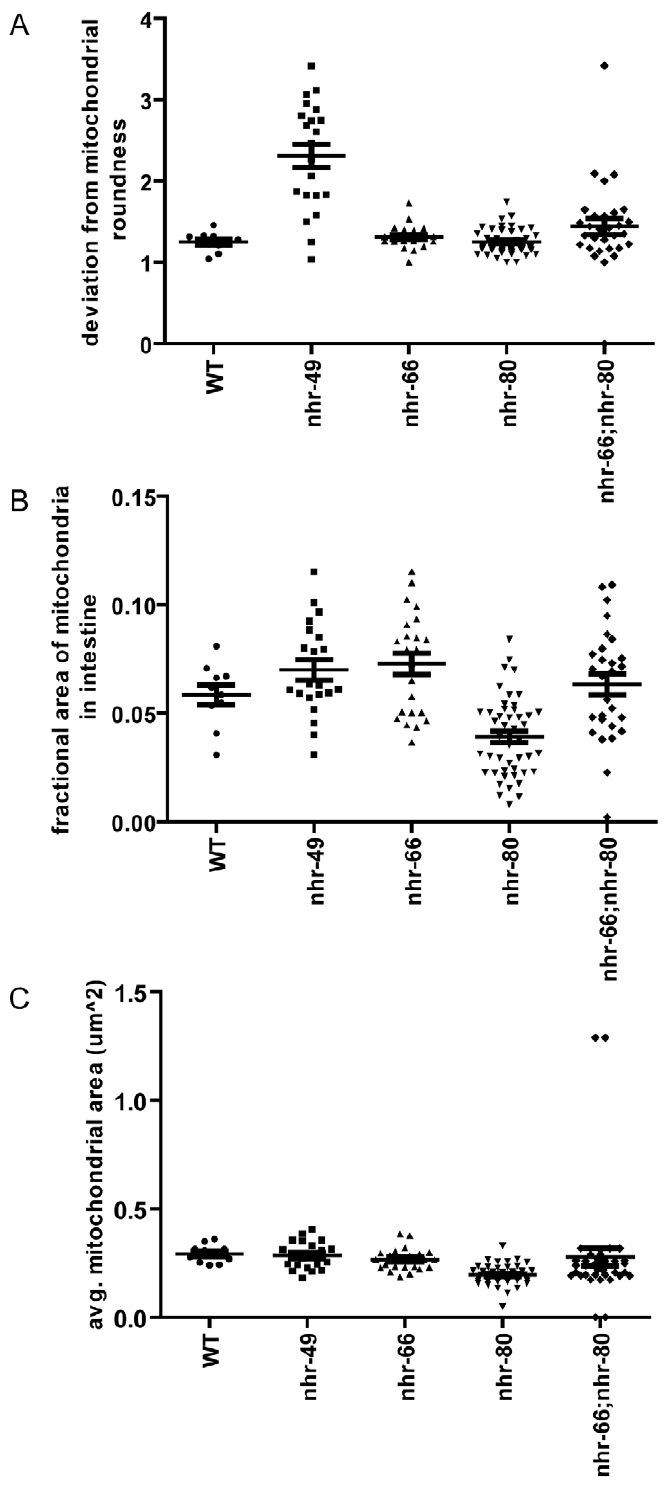
Figure 7. nhr-49 , nhr-66 , and nhr-80 animals have abnormal mitochondrial phenotypes. (A) Quantification of mitochondrial size in WT, nhr- 49 , nhr-80 , nhr-66 and nhr-66; nhr-80 animals. Each point represents the average size of all the intestinal mitochondria examined per section. P-values were obtained using the unpaired t-test with Welch’s correction for unequal variance. This analysis showed that the difference between nhr-80 animals and wild-type is statistically significant with a p-value , 0.0001. (B) Quantification of mitochondrial fractional area in WT, nhr-49 , nhr-80 , nhr-66 and nhr-66; nhr-80 animals. Each point represents the average fractional area ( m m 2 ) of the examined mitochondria per section. P-values were obtained using the unpaired t-test with Welch’s correction for unequal variance. This analysis showed that the difference between nhr-66 and nhr-80 animals compared to wild-type was statistically significant with p-values of 0.0440 and 0.0025 respectively. (C) Quantification of mitochondrial shape in WT, nhr-49 , nhr-80 , nhr-66 and nhr-66; nhr-80 animals. Each point represents the average number of mitochondrial turns in the section examined. P-